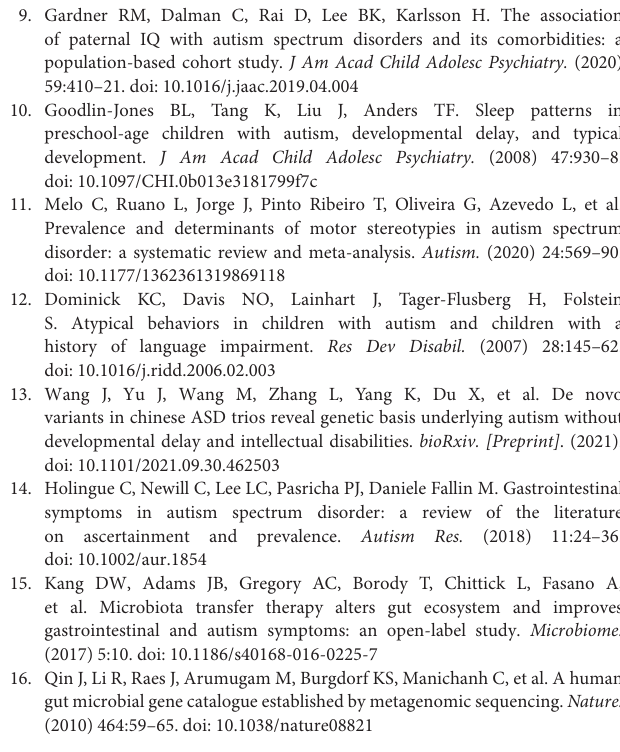
Supplementary Figure 1 | Six measures of alpha diversity: Observed species index, Chao1 index, ACE index, Shannon index, Simpson index, and InvSimpson index in group ASD + DD, ASD-only, TD, and DD/ID. Each box plot represents the median, interquartile range, minimum, and maximum values. ∗ p < 0.05. Supplementary Figure 2 | Beta diversity analysis on fecal samples from ASD subgroups, DD/ID, and TD children. Bray-Curtis β -diversity indices of the fecal